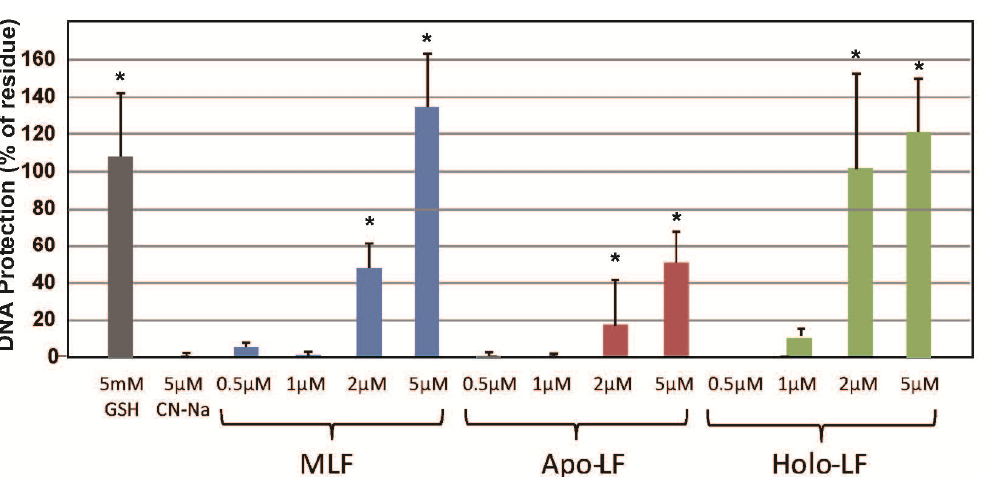
Figure 2. Dose responses and efficacy of LFs on calf thymus DNA strand breaks by UV irradiation in the presence of H O . Electrophoresis of calf thymus DNA using an agarose 2 2 gel (1.0%) was performed following exposure to UV (254 nm) irradiation with 5 mM H Reactions were conducted for 10 min at room temperature. DNA protection (%) was calculated based on the densitometry of EtBr-stained bands vs. a non-treated sample (Control). Data are presented as the mean ± S.D. of triplicate determinations. * p < 0.05 compared to the CN-Na (negative control) value was considered as a statistically significant difference.